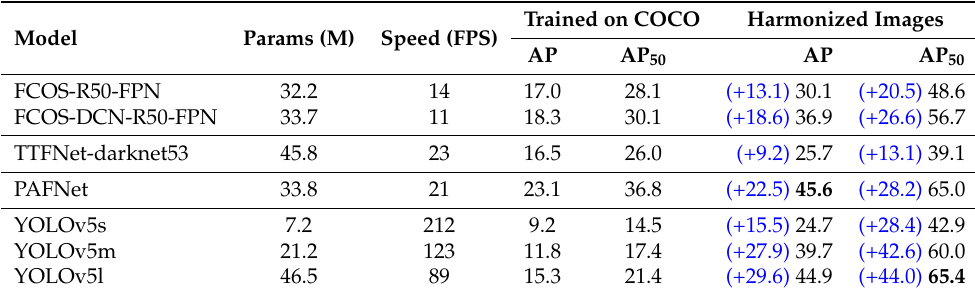
Table 1. Comparison of state-of-the-art models on real victim images. The best results are highlighted in bold